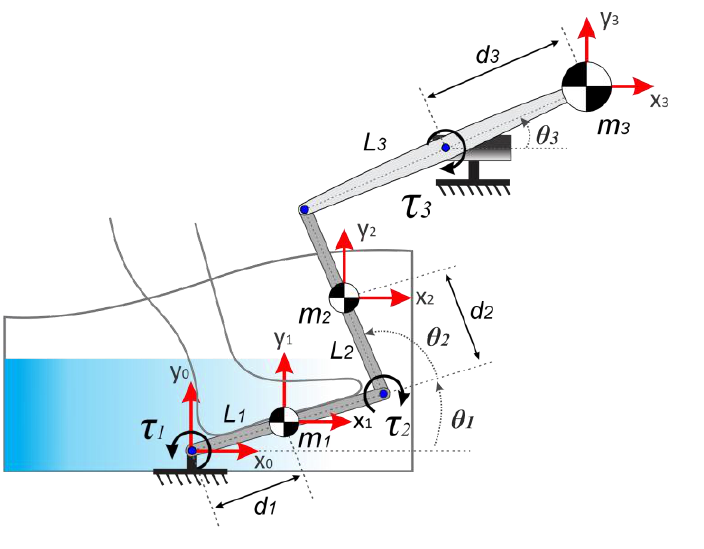
Figure 5. Torque diagram.